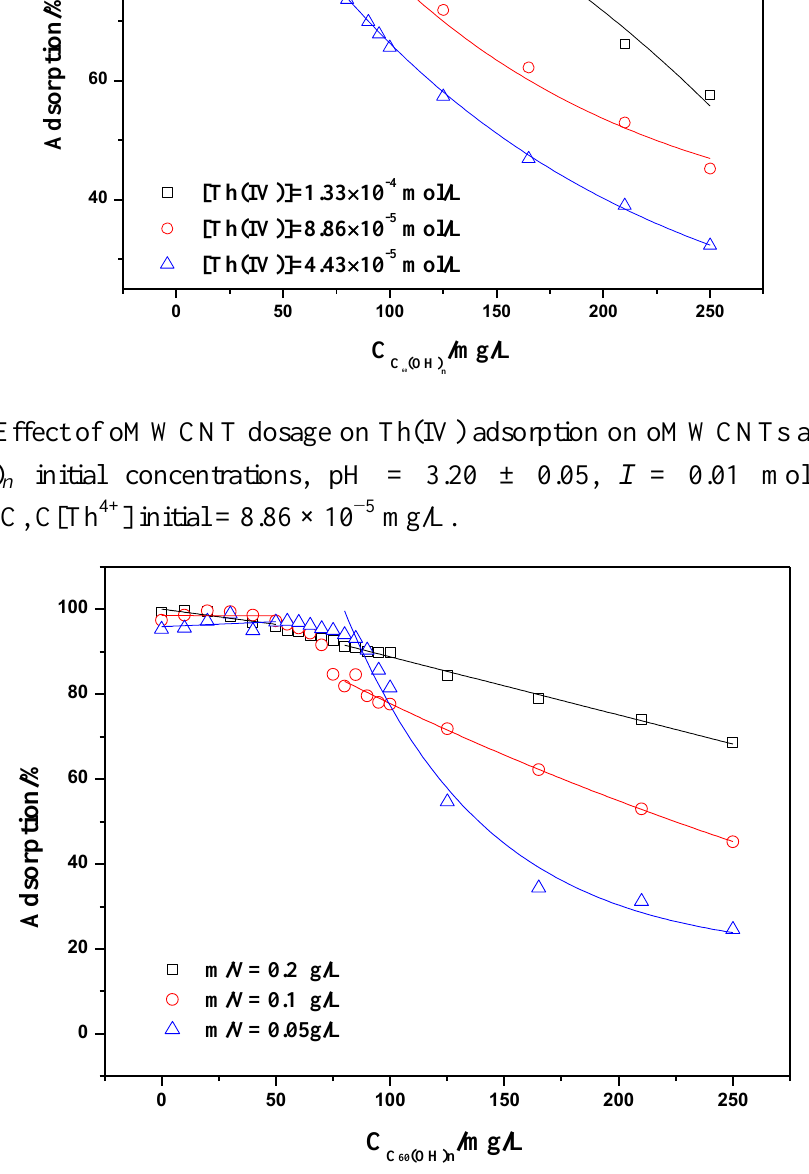
Figure 11. Effect of Th(IV) initial concentrations on Th(IV) adsorption onto oMWCNTs as a function of C (OH) initial concentrations, m/V = 0.1 g/L, pH = 3.20 ± 0.05, 60 n I = 0.01 mol/L NaNO , T = 25 ± 1 °C. 3